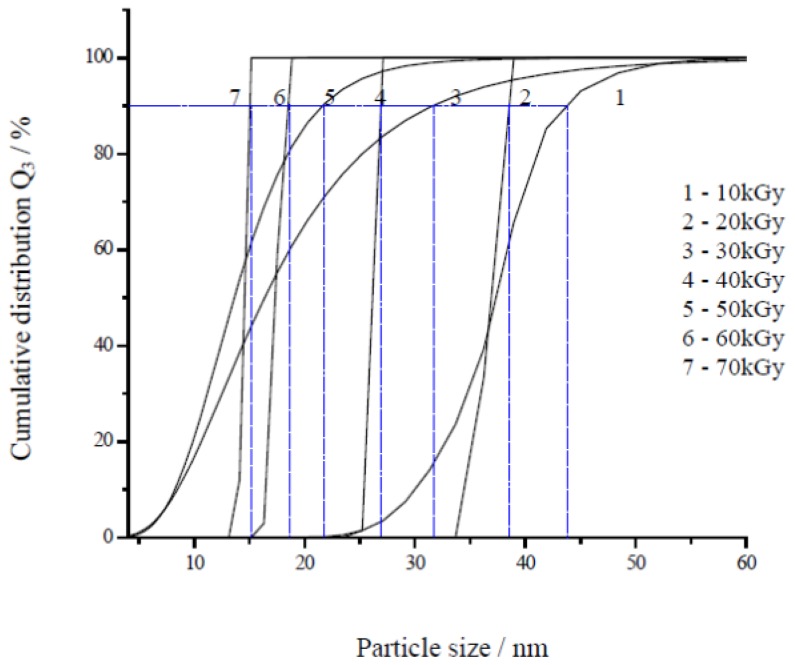
Cumulative distribution of particle size of monodispersed Ag nanoparticles synthesized from AgNO3 concentration of 4.2 × 10−4 M in 5 wt% PVA at different absorbed doses of (1) 10, (2) 20, (3) 30, (4) 40, (5) 50, (6) 60, and (7) 70 kGy.